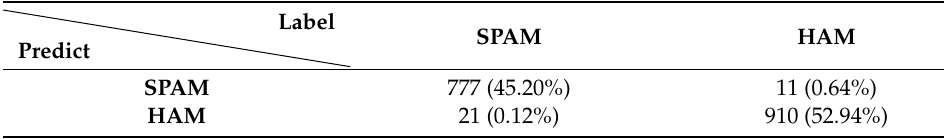
Table 8. Overall result of model classification approaches.